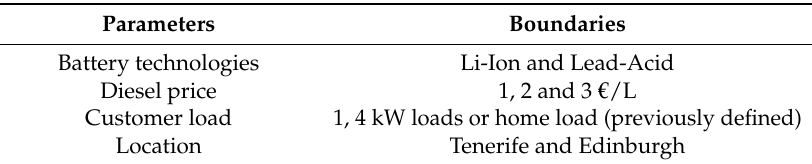
Table 5. Sensitive